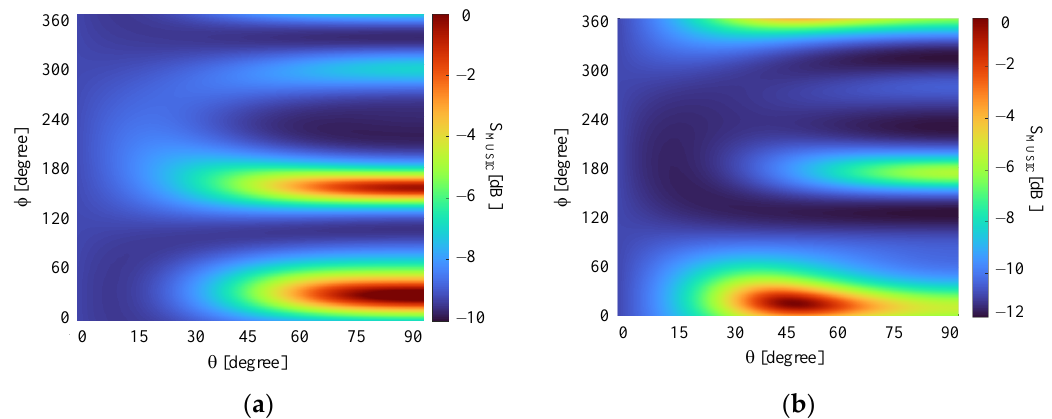
Figure 18. S MUSIC plots for the array of four isotropic radiators: ( a ) Case 1; ( b ) Case 5.